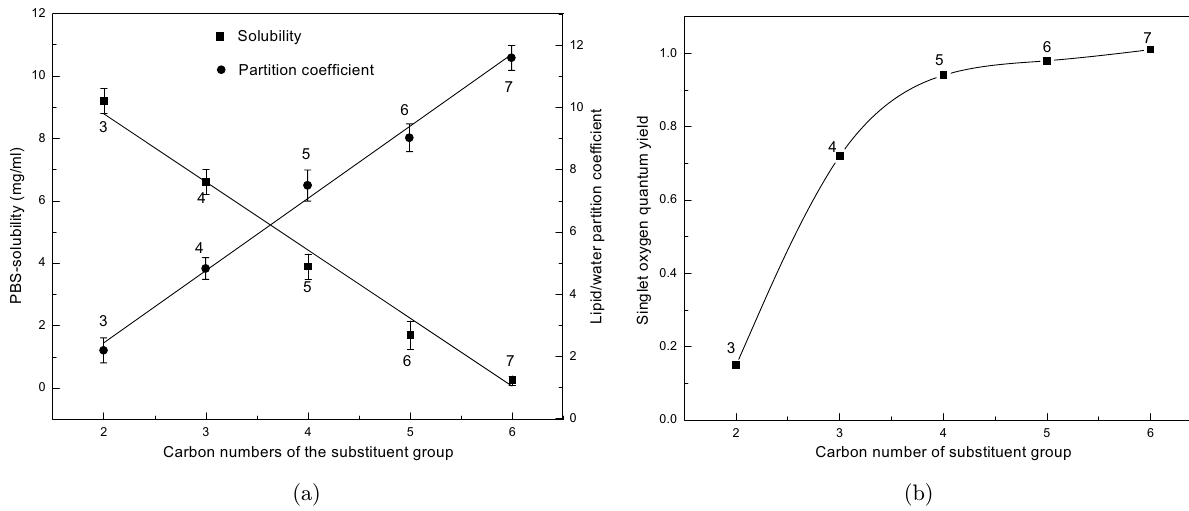
Fig. 5. (a) Plot of the PC or the solubility of 3 – 7 to the carbon atom number in the substituent. (b) Plot of the singlet oxygen quantum yield of 3 – 7 to the carbon atom number in the